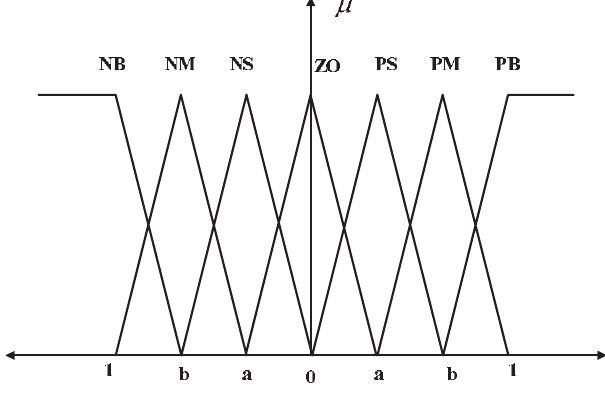
Fig. 9. Typical membership functions for the fuzzy controller.